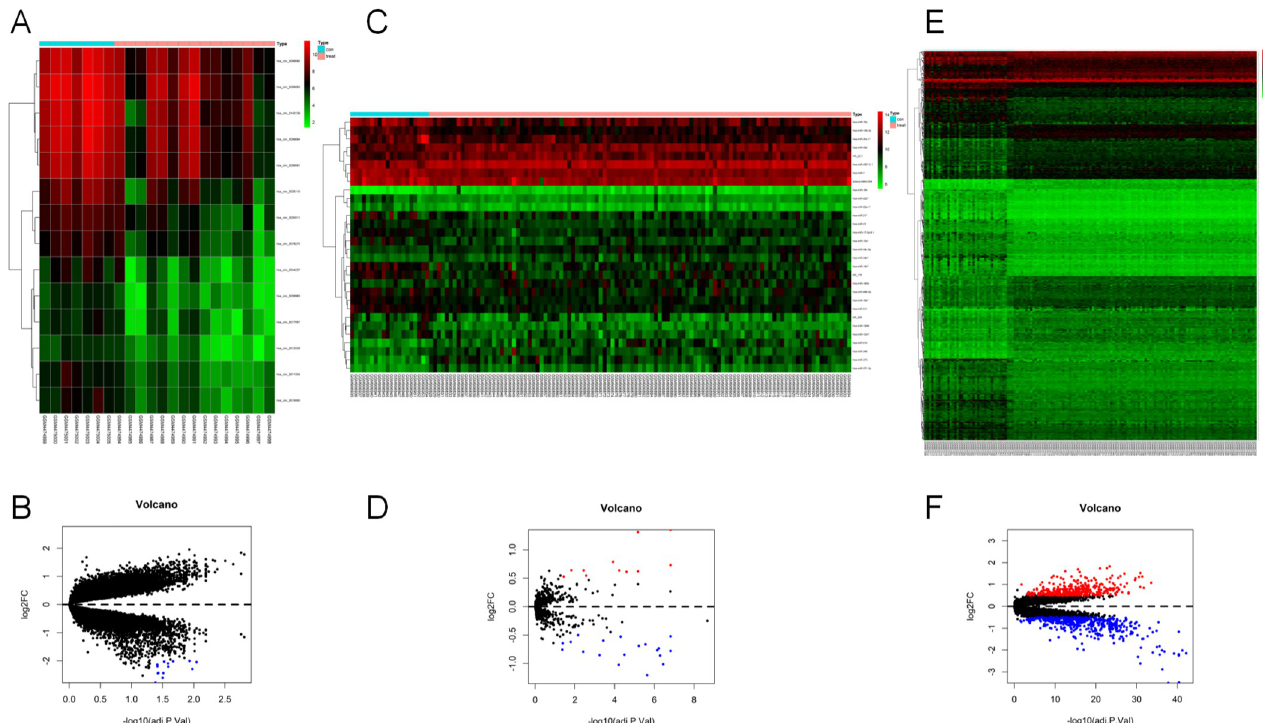
Fig 3. Heatmaps and volcano maps. A and B, GSE148602; C and D, GSE36946; E and F, GSE36961. The heat map shows high expression in red and low expression in green. The volcano map shows high expression in red and low expression in